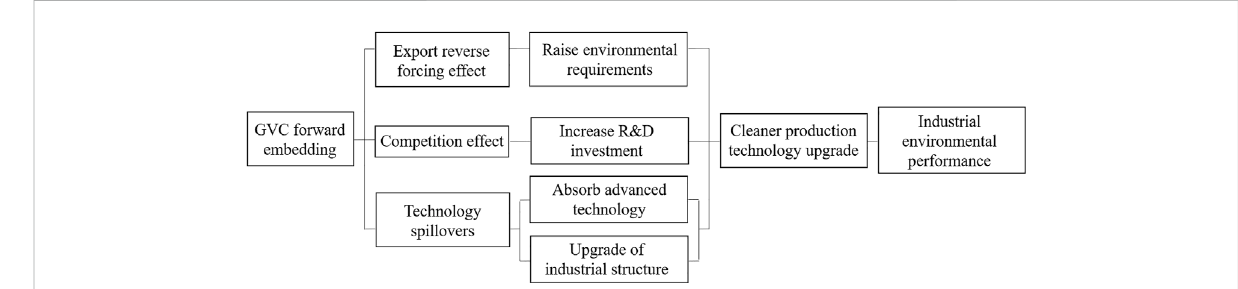
FIGURE 1 Impact mechanism of GVC forward embedding on industrial environmental performance.